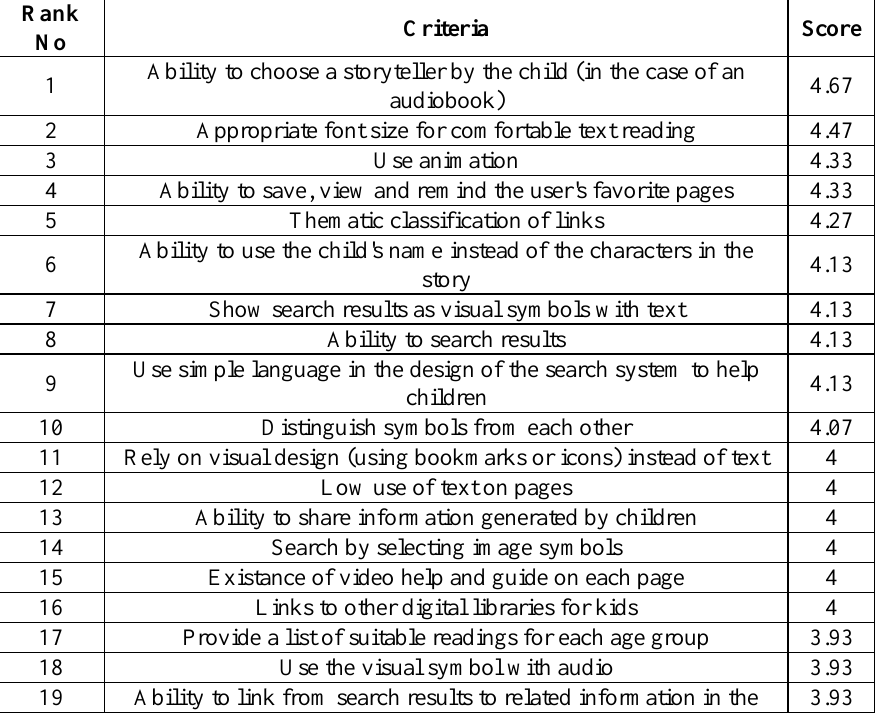
Table 6. Results of the third round of prioritization